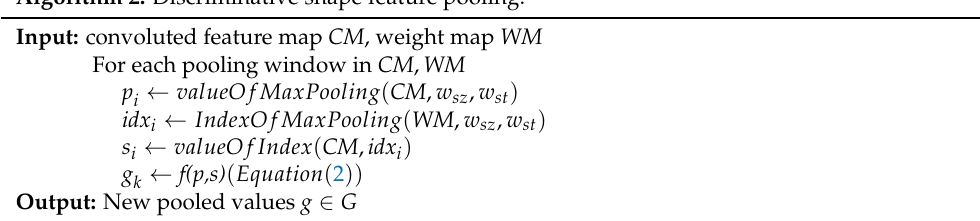
Algorithm 2: Discriminative shape feature